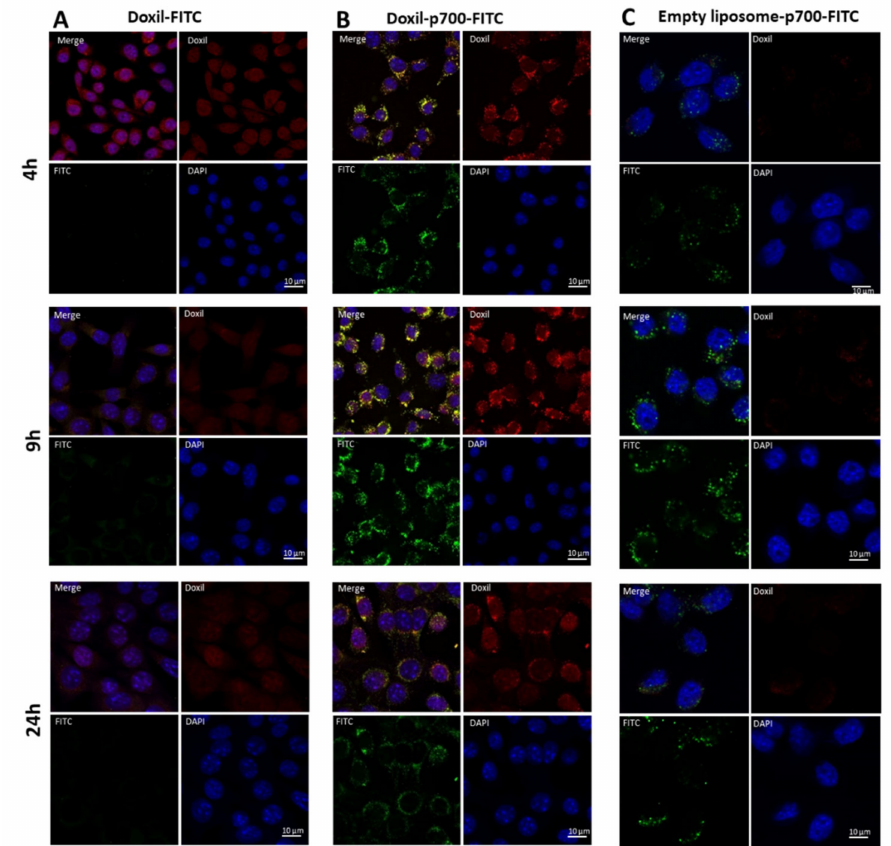
Figure 3. Uptake of Doxil, Doxil-p700 and empty liposome-p700 by the 4T1 cell line with time. 4T1 mouse breast cancer cells were treated with ( A ) Doxil-FITC; ( B ) Doxil-p700-FITC or ( C ) empty liposome-p700 at 275 nM for 4, 9 and 24 h at 37 ◦ C and then imaged by confocal microscopy. Red staining is doxorubicin, green staining is FITC on the peptide conjugate and blue DAPI nuclear stain. The experiment was then repeated for H5V, MCF-7 and HuDMEC (Figure 4), however in this case only data for 9 h are shown as maximal fluorescence was seen at this time point. Again, for H5V and MCF-7 (Figure 4A,B respectively), the p700 sequence greatly enhanced uptake of FITC and doxorubicin, with no green and little red fluorescence observed in the cells treated with Doxil-FITC only. However, for HuDMEC, no detectable green or red fluorescence was observed with either Doxil-FITC or Doxil-p700-FITC, suggesting little internalisation of the drug (Figure